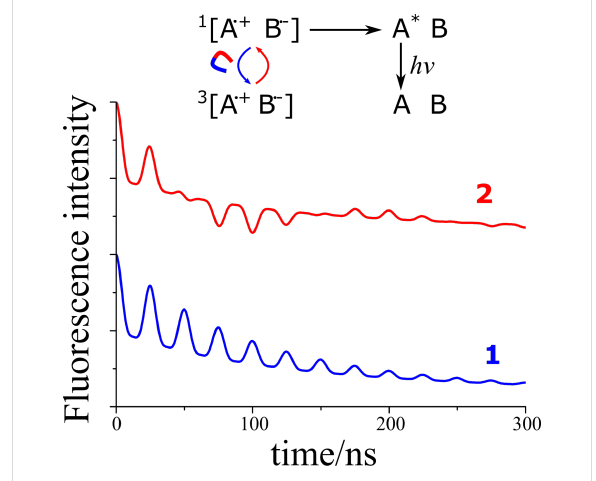
Figure 7: Calculated time-resolved MFE traces as obtained by moni- toring recombination fluorescence, resulting from recombination of radical ion pairs in singlet state (such a situation is frequently met upon pulsed radiolysis of non-polar solutions of electron and hole acceptors). Magneto-sensitive interconversion (indicated in the reac- tion scheme) results in oscillations (quantum beats) of the singlet-state population, which manifest themselves in the fluorescence of A * . Quantum beats can be due to HFCs (curve 1, HFC-driven quantum beats) and also due to Δ g ≠ 0 (curve 2, HFC-driven and Δ g -driven quantum beats are superimposed). For convenience of the reader, trace 2 is shifted along the vertical axis (at t = 0, the fluorescence in- tensity is the same in both cases). Here we consider a radical ion pair with equivalent magnetic nuclei with HFC of 20 MHz; for curve 2, the Δ g -term is taken equal to 5 MHz. Fluorescence decays due to recom- bination of the SCRP (additionally, quantum beats decay due to relax-